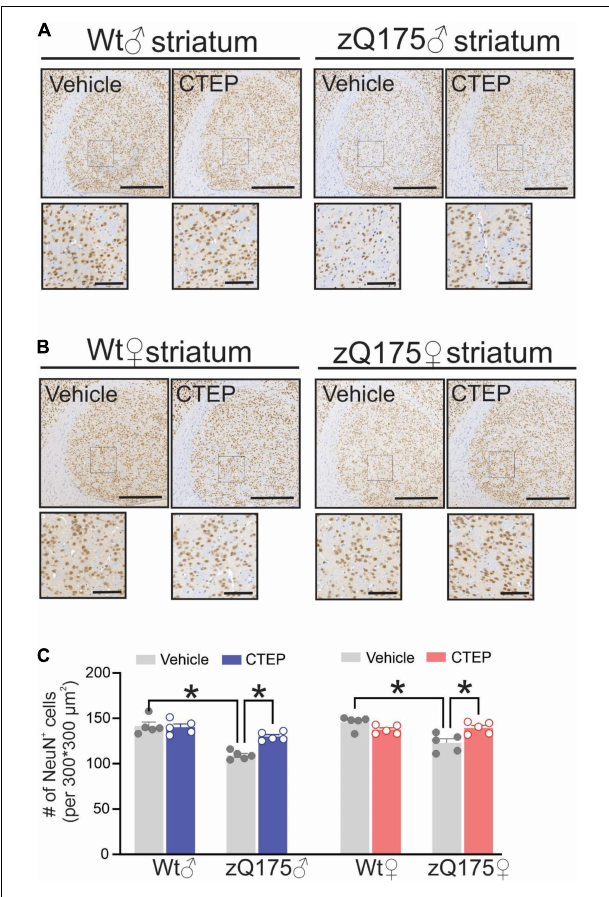
FIGURE 5 | Effect of chronic administration of CTEP on neuronal survival in male and female zQ175 mouse striatum. Representative images of staining for neuronal nuclei (NeuN)-positive cells in striatal brain slices from 15-month-old male (A) and female (B) heterozygous zQ175 (zQ175) and wild-type (Wt) mice after 12 weeks of treatment with either vehicle or CTEP (2 mg/kg/48 h). Scale bar = 500 µ m for whole striatum and 100 µ m for magnified areas. (C) Quantification of the number of NeuN-positive cells in striatal brain slices from 15-month-old male and female zQ175 and Wt mice after 12 weeks of treatment with either vehicle or CTEP. Data are quantified from two different 300 × 300 µ m 2 striatal regions of 6 sections per mouse and five independent mouse brains from each group were used for analysis. Data are mean ± SEM. * P < 0.05 by three-way analysis of variance (ANOVA) and Tukey’s multiple comparisons test.